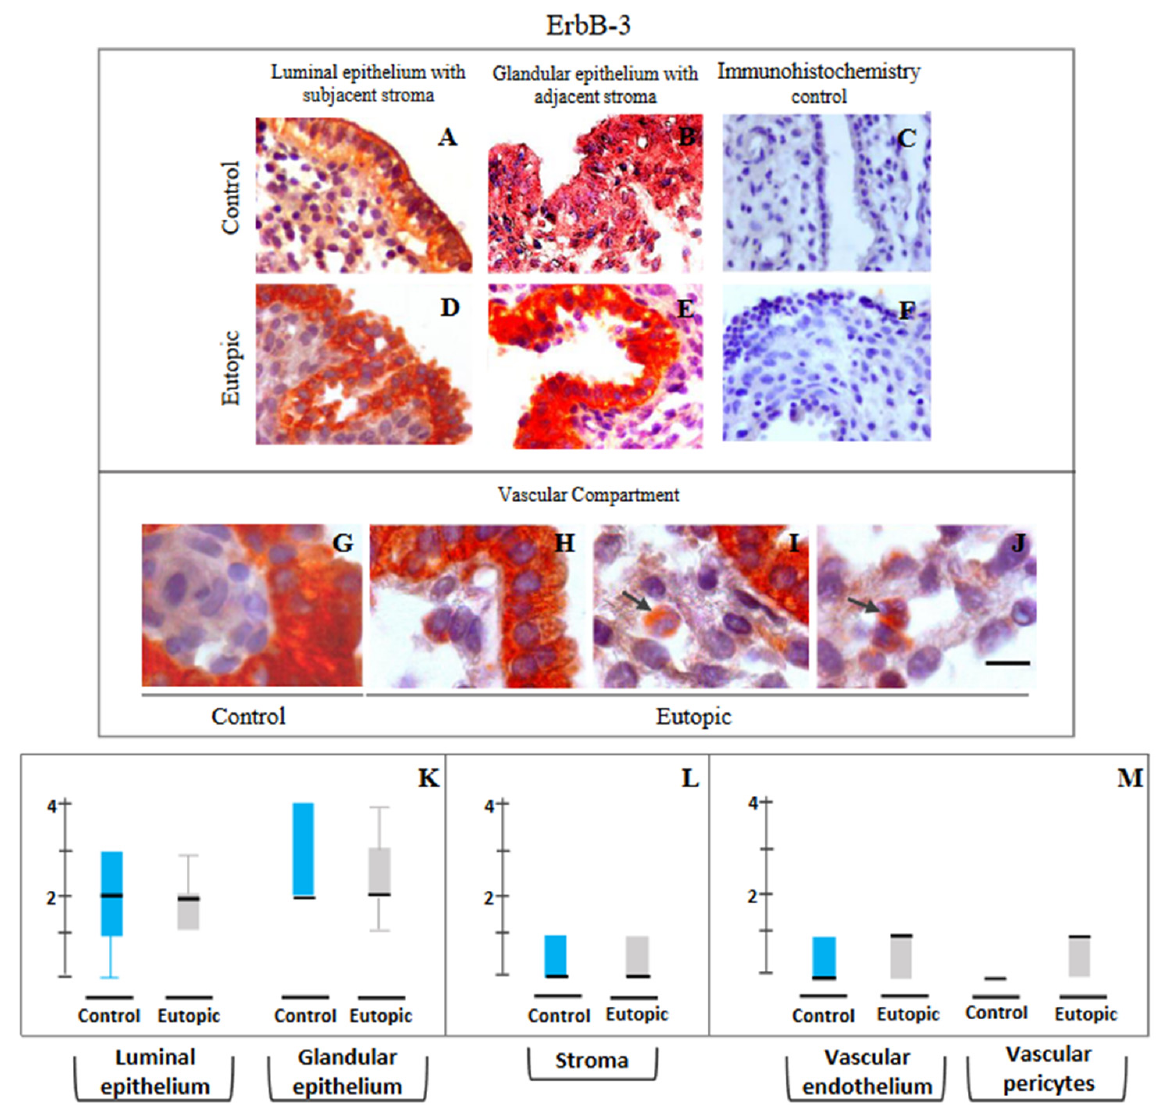
Figure 4. Representative photomicrographs of ErbB-3 ( A – J ) expressions in luminal epithelium along with subjacent stroma ( A , D ), glandular epithelium along with adjacent stroma ( B , E ) and in cells of the vascular compartment ( G – J ) in endometrial samples collected from endometriosis-free control women of group 1 ( A – C , G ) and stage IV ovarian endometriosis patients of group 2 ( D – F , H – J ). Semi-